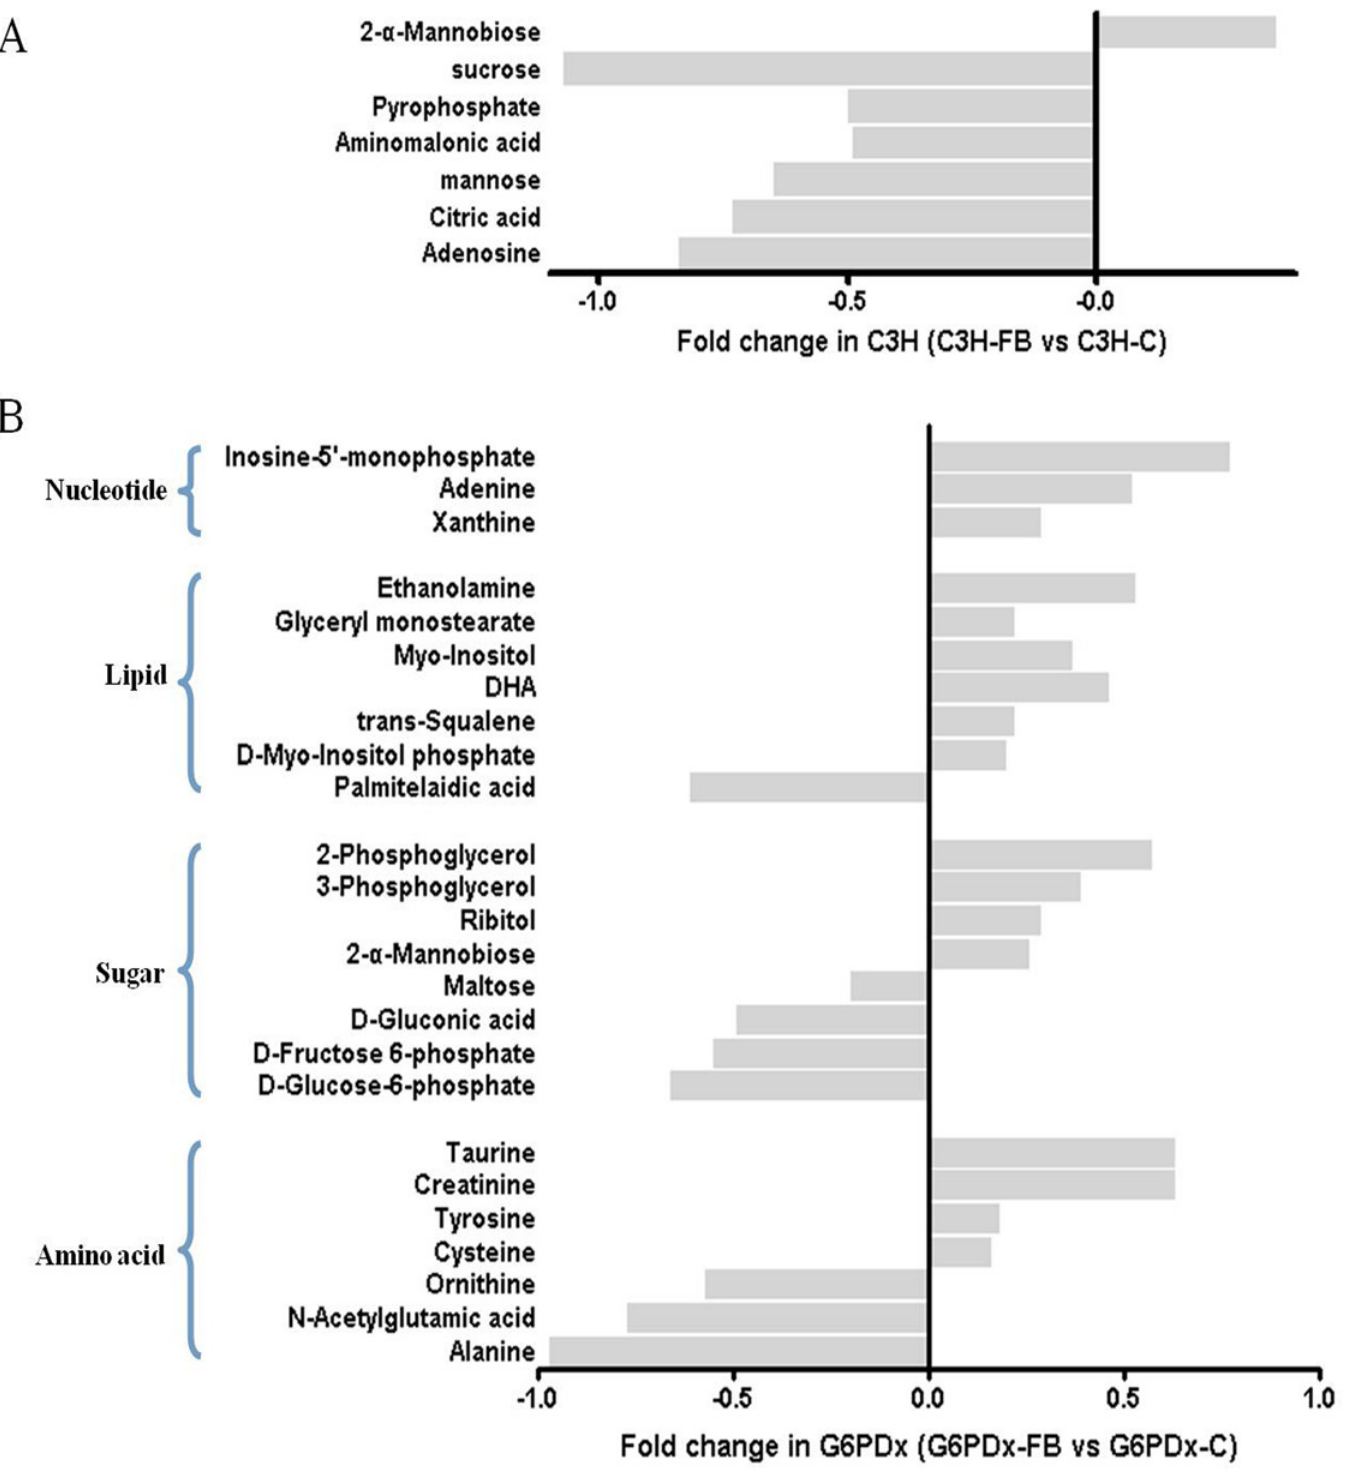
Fig 5. Relative levels of metabolites detected with significant changes in the liver of the C3H-FB vs. C3H group and the G6PDx-FB vs. G6PDx group. Seven and 25 differential metabolites were significantly altered in C3H-FB mice compared with C3H control mice (A) and G6PDx-FB mice compared with G6PDx control mice (B)